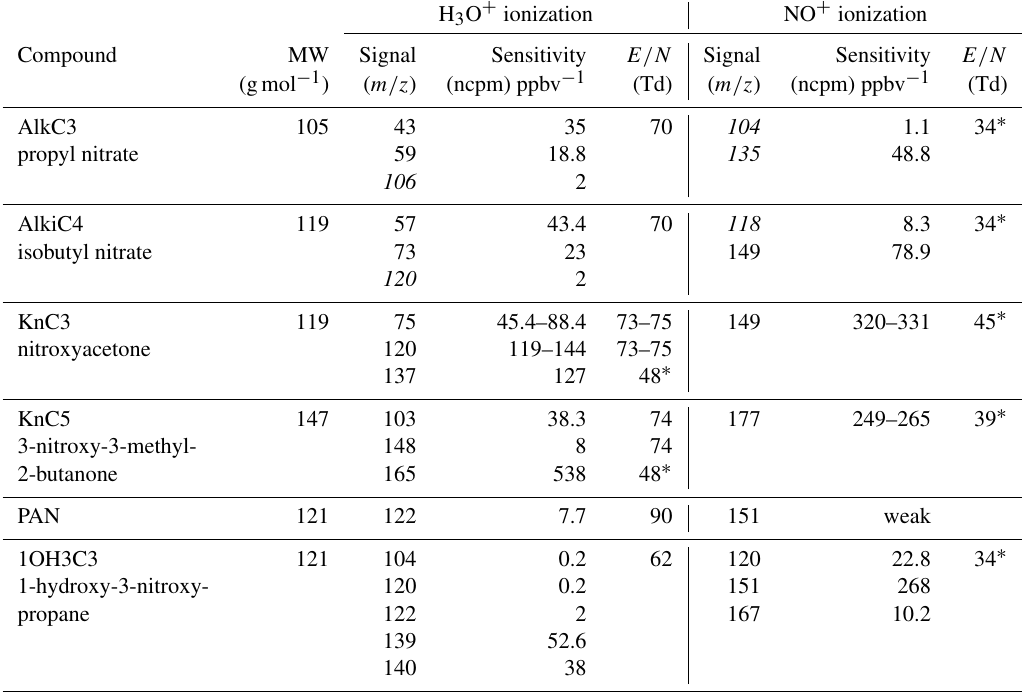
Table 2. Organic nitrates normalized sensitivity as a function of the ionization mode.